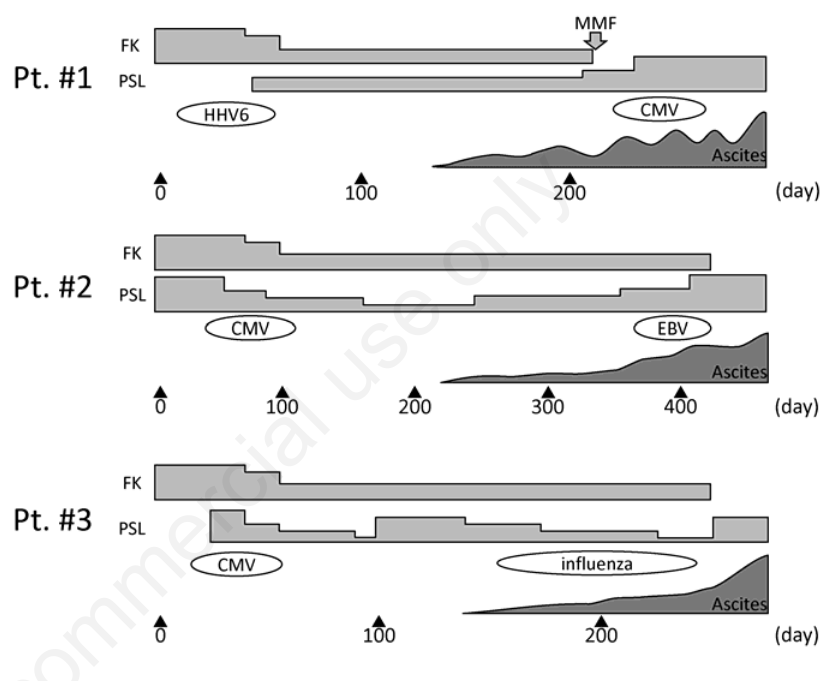
Figure 1. Clinical course of the three patients. Ascites developed beyond 100 days after allogeneic hematopoietic stem cell transplantation. All patients suffered from multiple viral